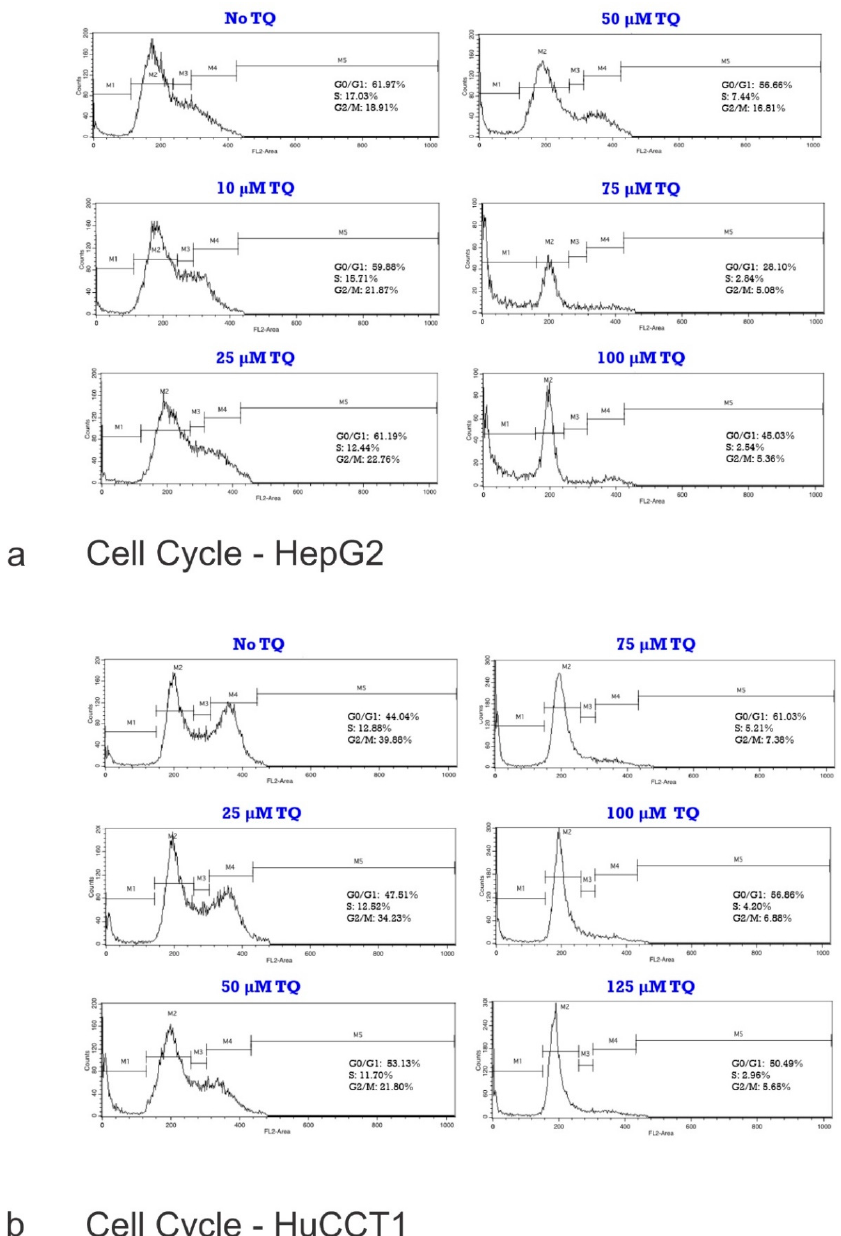
Figure 2. ( a ) Distribution of Cell Cycle Phases in HepG2 cell lines. To determine whether the cytotoxic effect of TQ is associated with disruption of the cell cycle, changes in cell cycle progression of the HepG2 cell line were investigated. Cells were treated with increasing doses of TQ for 24 h, followed by PI staining of the DNA content. Flow cytometry was employed to quantify the cell populations in the different cell cycle phases (sub-G1, G1, S, and G2/M phases). The flattening and re-shaping of the curve is remarkable as the concentration of TQ increases (see text for details). ( b ) Distribution of the Cell Cycle Phases in the HuCCT1 cell lines. To determine whether the cytotoxic effect of TQ is associated with disruption of the cell cycle, changes in the cell cycle progression of the HuCCT1 cell line were investigated. Cells were treated with increasing doses of TQ for 24 h, followed by PI staining of the DNA content. Flow cytometry was employed to quantify the cell populations in the different cell cycle phases (sub-G1, G1, S, and G2/M phases). The flattening and re-shaping of the curve is remarkable as the concentration of TQ increases (see text for